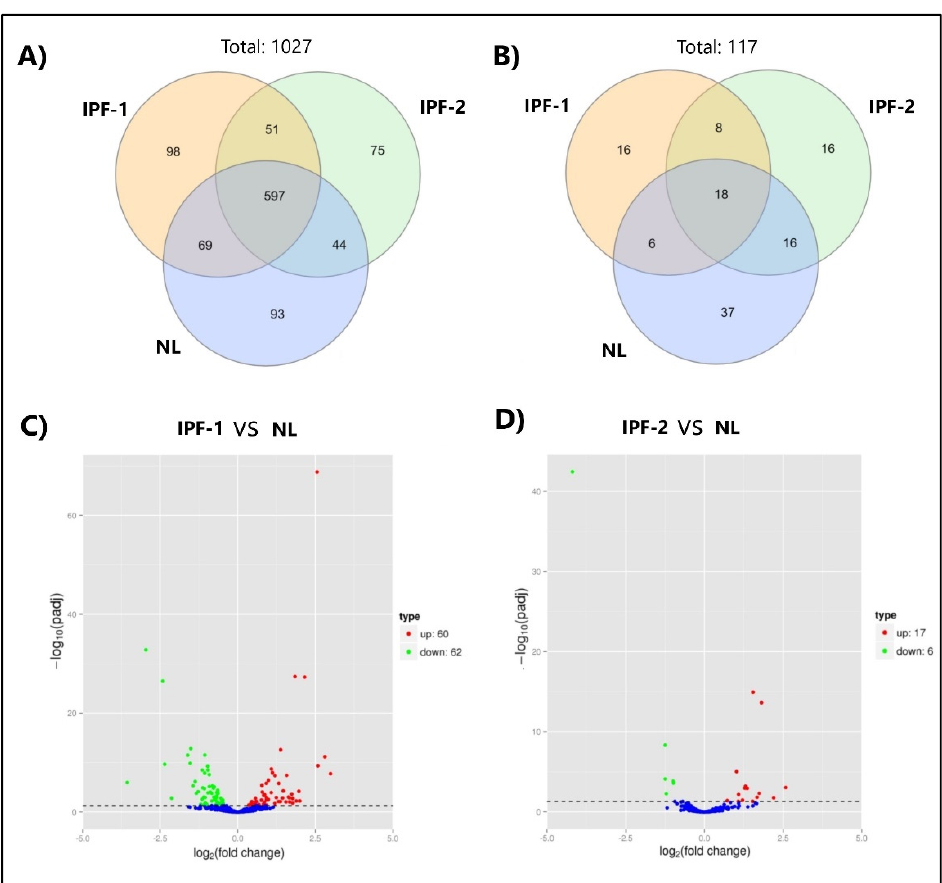
Figure 2. miRNAs expressed in EVs of IPF fibroblasts. ( A ) Venn diagram shows known miRNAs shared in IPF-1, IPF-2, and NL groups. ( B ) Venn diagram shows novel miRNAs shared in IPF-1, IPF-2, and NL groups. ( C , D ) Volcano plots of differentially expressed miRNAs within EVs from IPF-1 vs. NL and IPF-2 vs. NL. The x -axis shows the fold change of miRNAs expression, and the y -axis shows the statistical significance ( p adjusted threshold < 0.05), The dot representing each miRNA, blue dots indicate no significant difference miRNA, red dots indicate significant upregulation of miRNA, green dots indicate significant difference by miRNA.